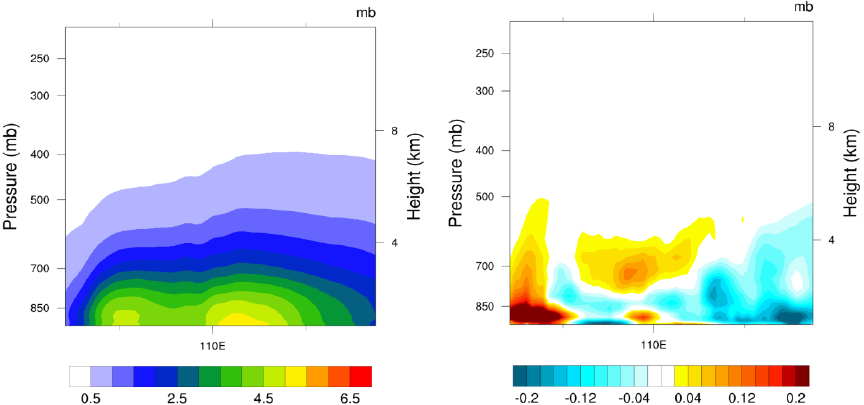
Figure 8. Vertical distributions of annual average sulfate aerosol concentrations ( µ g kg − 1 ) in the eastern China (24–43 ◦ N, 101–126 ◦ E) during the daytime ( left ) and the difference between daytime and nighttime ( right ) in 2010.